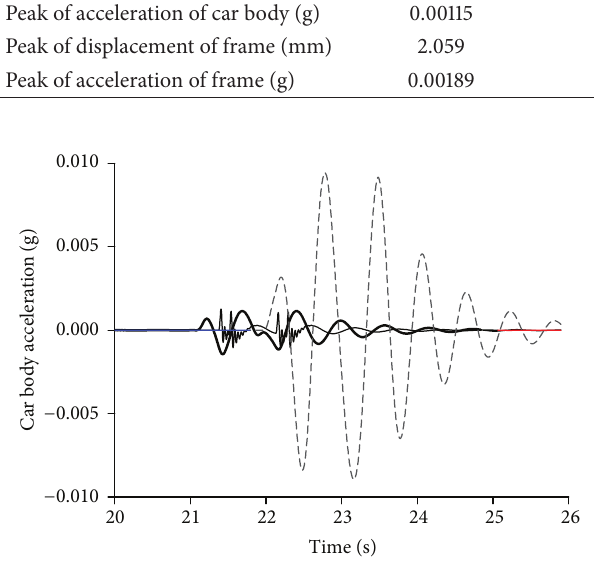
Figure 6: Vehicle acceleration corresponding to different stimula- tions. Bold line: voided sleepers; solid line: weld joint irregularity; dashed line: vertical profile irregularity.